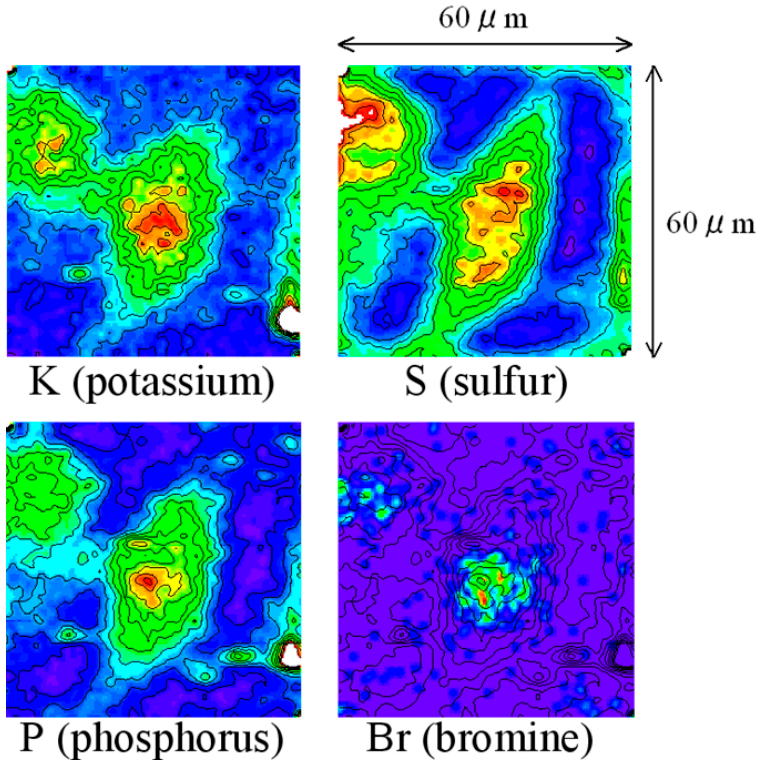
Figure 10. Elemental distributions of the endothelial cells of a blood vessel from a cow, obtained using a micro-PIXE camera with 2.6 MeV